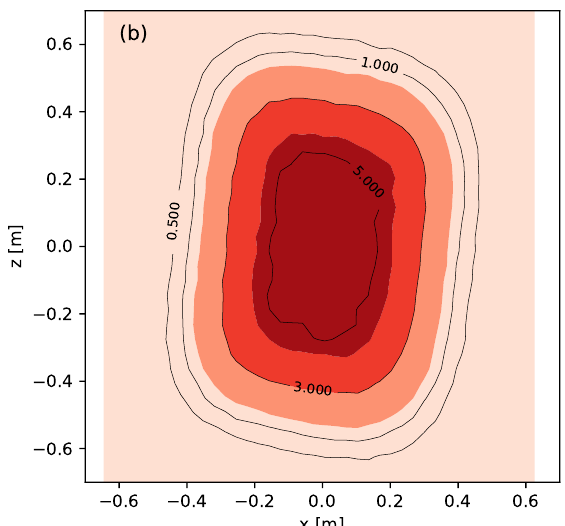
Figure 17. Experimental radiative flux distribution ( a ) and ray tracing simulation with SolTrace ( b ) for the heliostat array prototype. The isolines 0.500, 1.00, 3.00, and 5.00 correspond to irradiance in kW/m 2 .